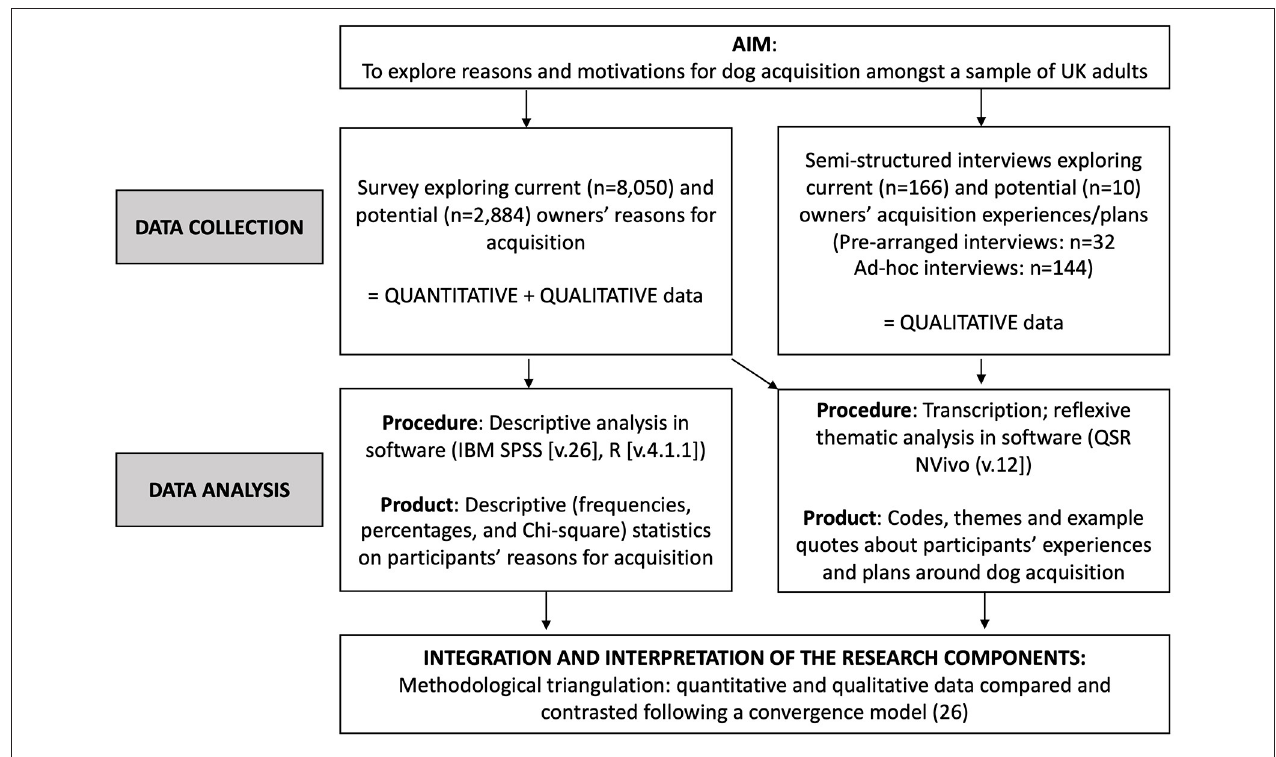
FIGURE 1 | Procedural diagram of the mixed-methods study design.